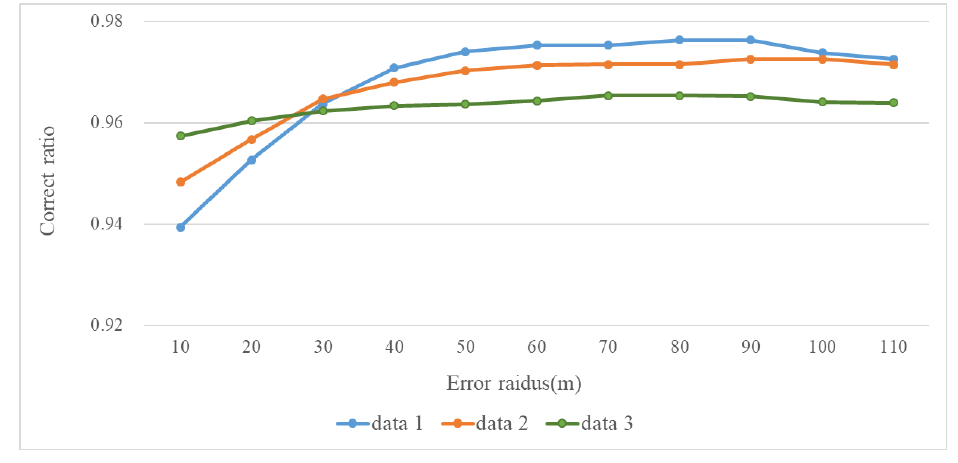
Figure 9. Accuracy comparison of this method at eleven error radii.